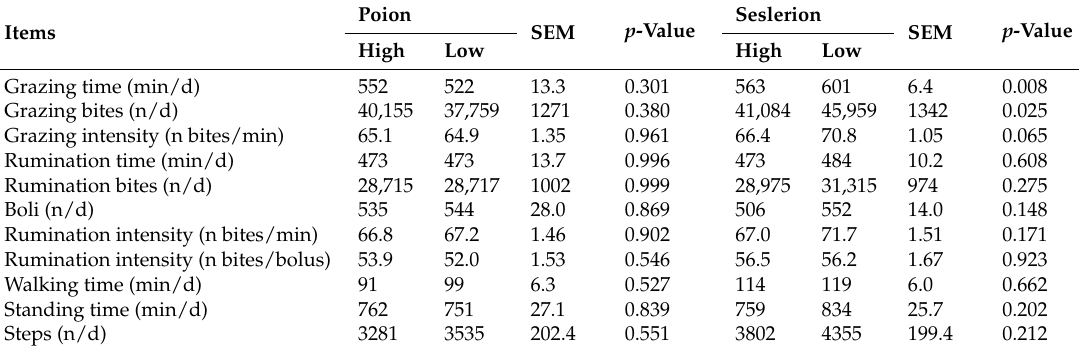
Table 3. Feeding and locomotion behavior of dairy cows grazing on two pastures (Poion and Seslerion) as affected by different concentrate levels (High and